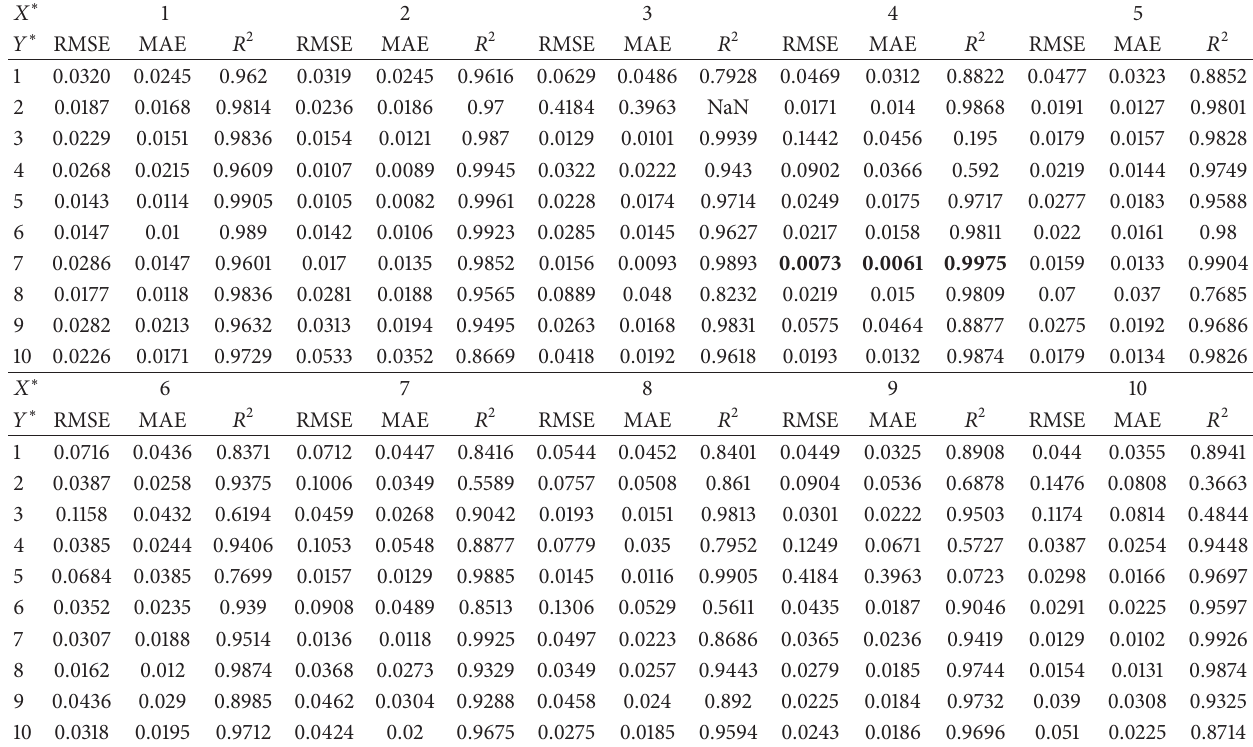
Table 4: The RMSE statistics of the ANN models in testing for two hidden layers.